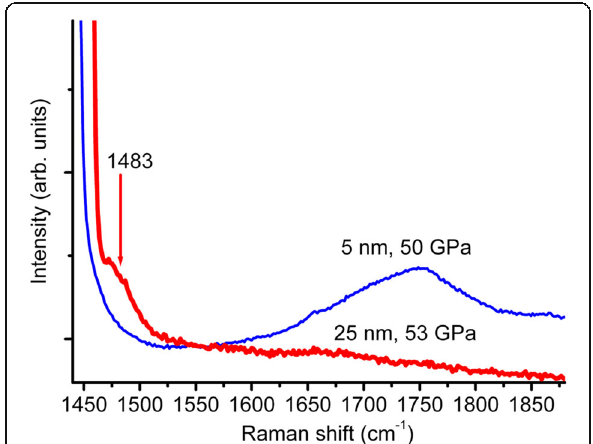
Fig. 7 Raman spectra of the 25- and 2 – 5-nm nanodiamond under a 50 GPa pressure. Excitation wavelength is 458 nm. An initial 25-nm nanodiamond band 1329 cm − 1 shifted to 1483 cm − 1 exactly in accordance with the pressure dependence (2) of Raman mode of diamond with the bulk modulus 443 GPa. An additional band of the 25-nm nanodiamond around 1800 cm − 1 showed a typical behavior for a G band of sp 2 -bonded carbon: disappearance of this band under pressure of 50 GPa